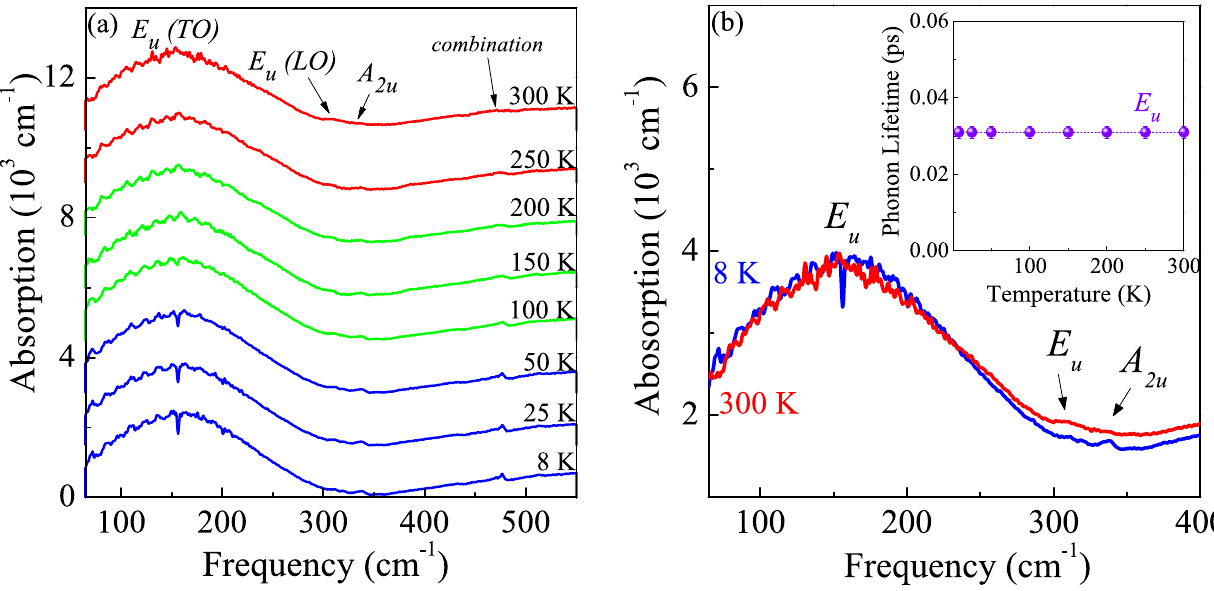
Fig. 2 Infrared absorption studies of 1T-HfS 2 as a function of temperature. a Infrared absorption spectra of 1T-HfS 2 as a function of temperature. The color scheme emphasizes the different phases, and the curves are offset for clarity. b Close-up view of the infrared response of 1T-HfS 2 on an absolute scale. The inset displays the phonon lifetime of the E u mode as a function of temperature. Error bars are on the order of the size of the data